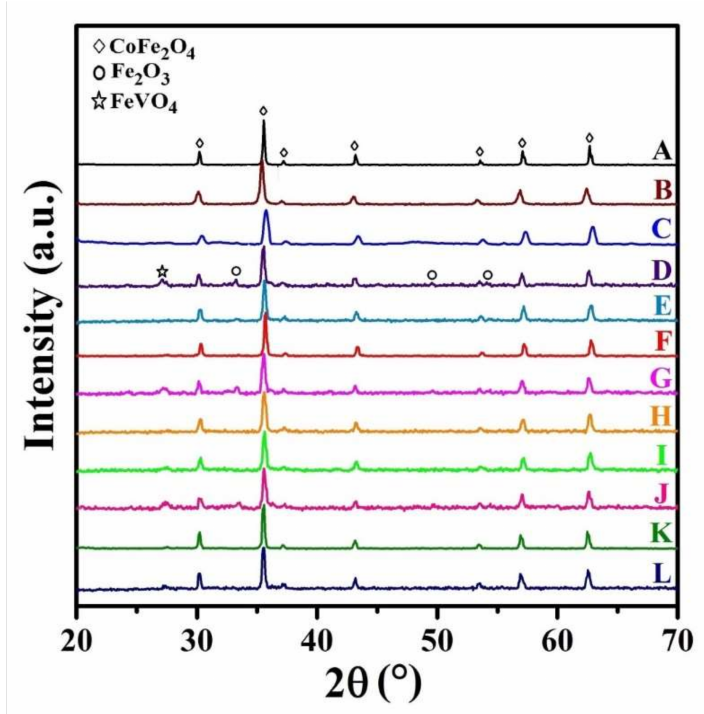
Figure 3. XRD patterns of the synthesized